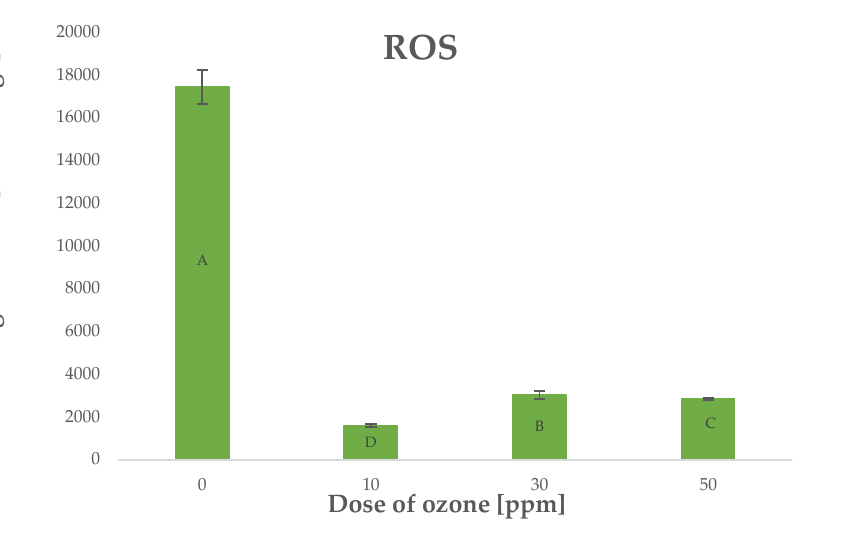
Figure 7. ROS generation in barley young plants depending on the dose of ozone ( n = 20): differences between the results for the dose of ozone treatment are marked with capital letters; the significance level is defined as p < 0.05.